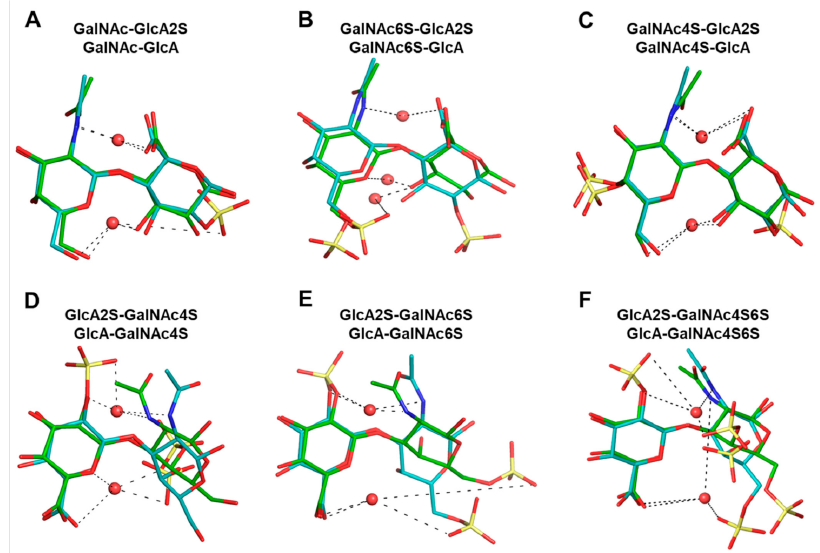
Figure 5. Comparison of topologies of representative sequences from 1 → 4- ( A – C ) and 1 → 3-linked ( D – F ) sequences . The backbones (nuclear atoms only) of the non-reducing end residues of selected disaccharides were aligned to evaluate the role of water-mediated interactions in topological pref- erences. Higher and lower sulfated sequences are shown in cyan and green sticks, respectively. Bridging water molecules are shown as red spheres. See Figures S13 and S14 for further